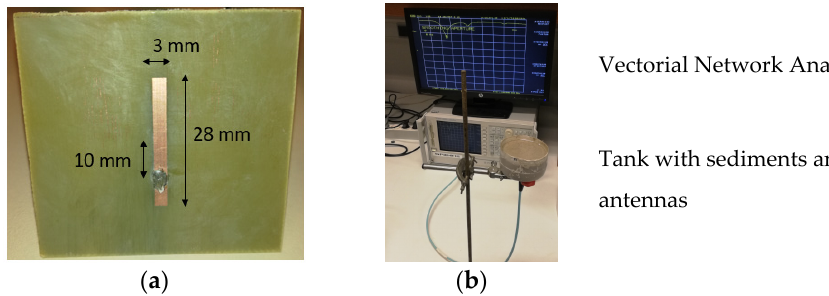
Figure 7. ( a ) Photography of the planar antenna produced on FR4; ( b ) experimental set-up used for the